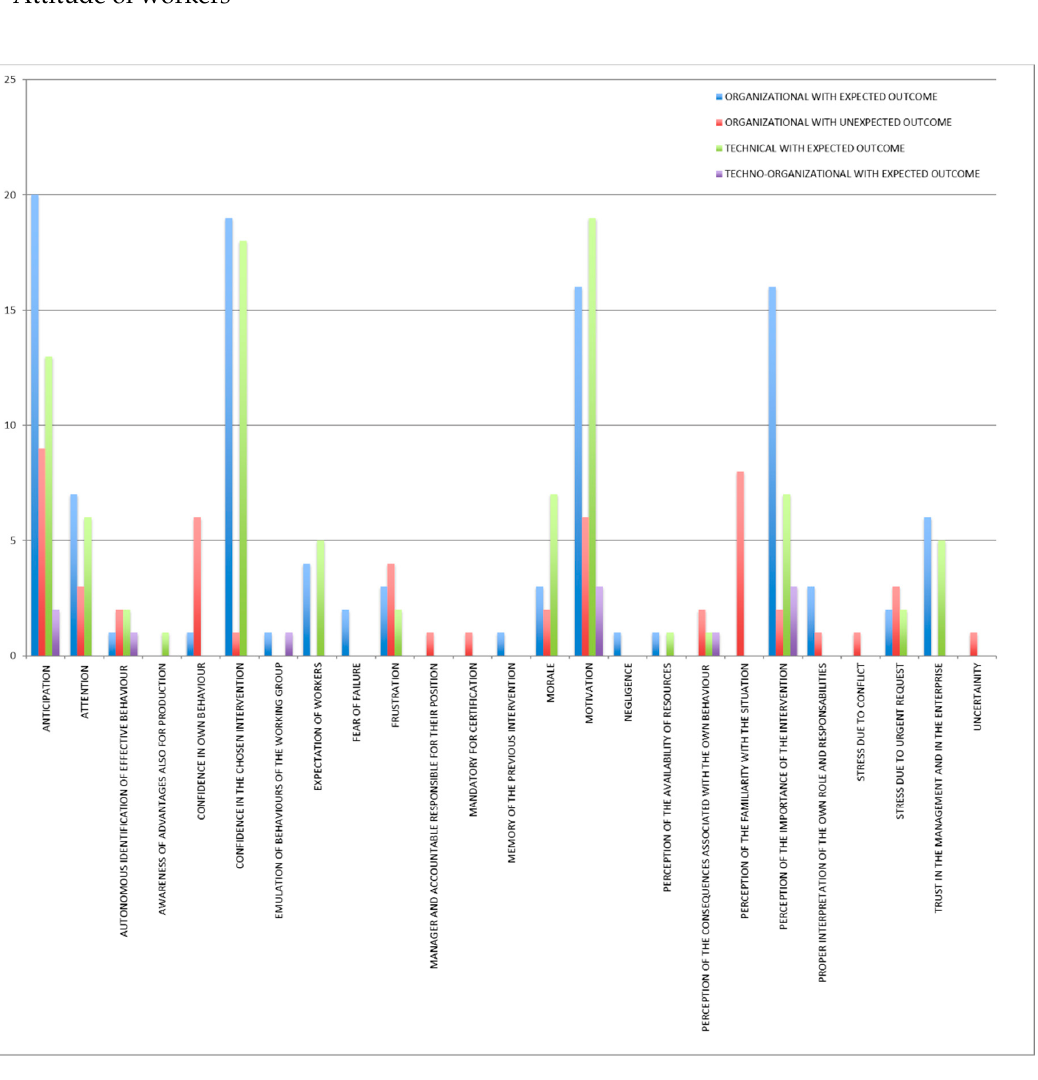
Figure 11. Comparison of mechanisms (in terms of number of occurrences).